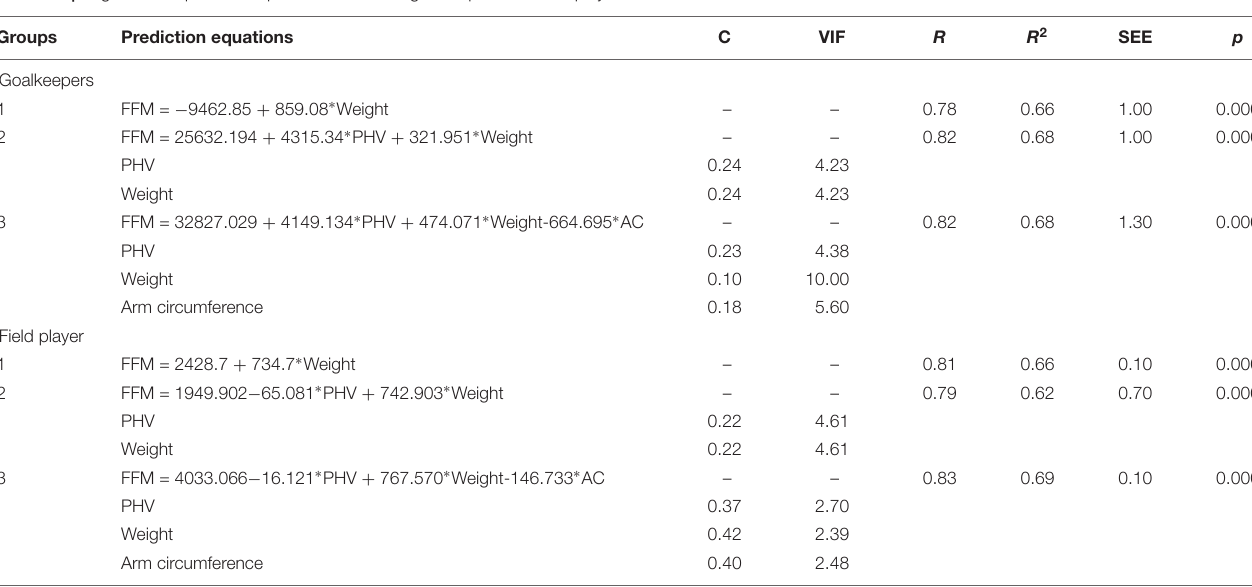
TABLE 3 | Regression equations to predict the FFM of goalkeepers and field players. Groups Prediction